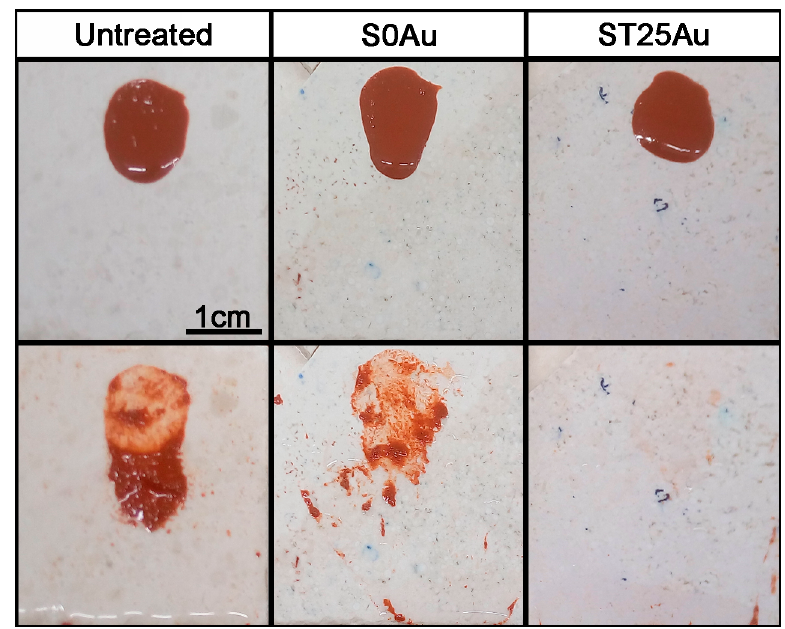
Figure 13. Photographs of the samples before and after the water streaming: untreated, S0Au and ST25Au. all photographs have the same scale.